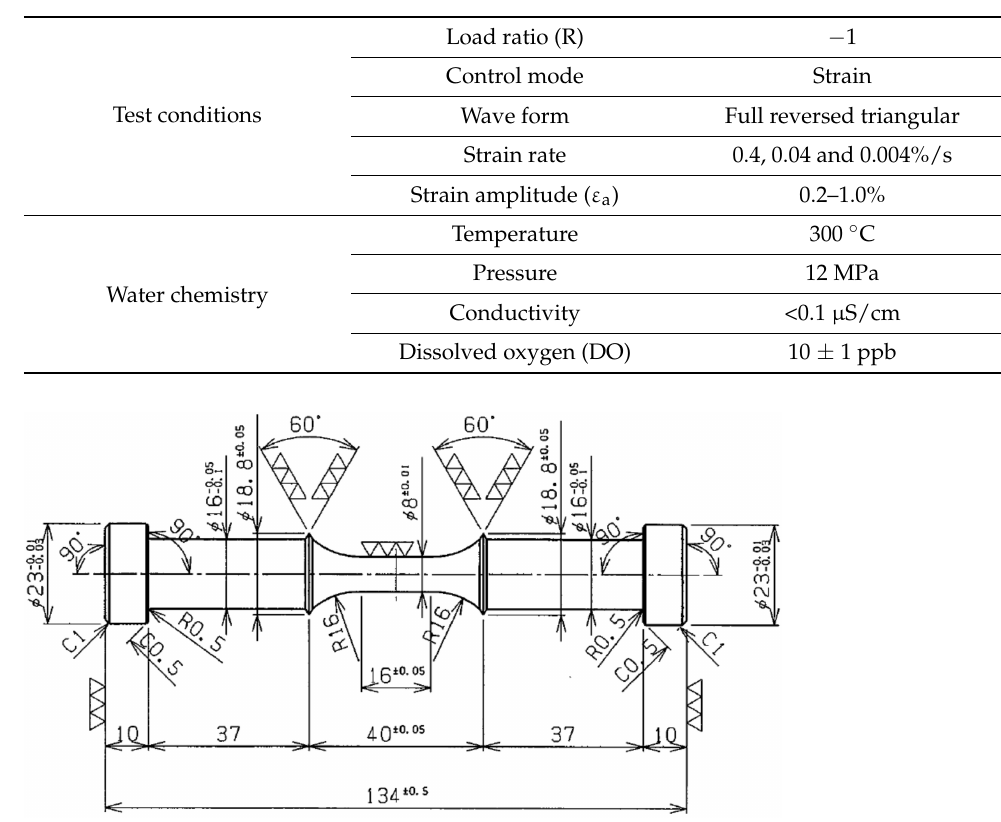
Figure 2. Optical observation of the Z3CN20.09M ASS. Table 2. LCF test conditions and water chemistry.